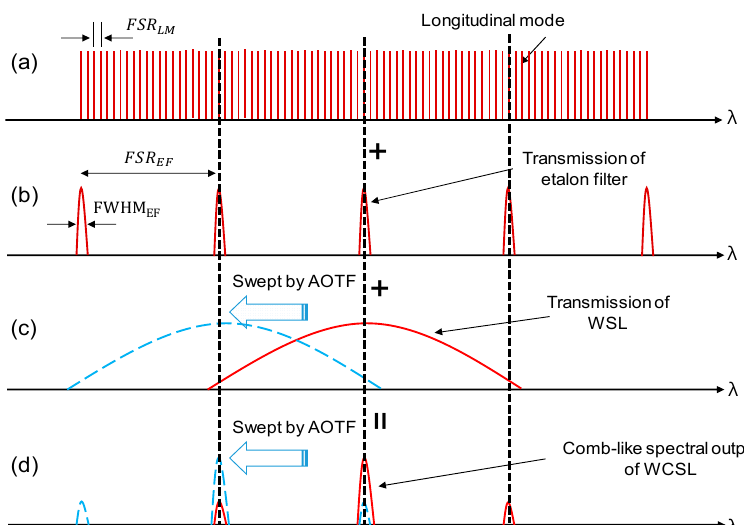
Figure 1. Generation of comb-like spectral laser source with narrow spectral linewidth by combining an etalon filter and an AOTF. ( a ) Longitudinal mode position corresponding to the round trip of the laser cavity; ( b ) transmission of the etalon filter; ( c ) transmission of conventional WSL; ( d ) comb-like spectral output of the WCSL. The transmission spectra swept by the AOTF for both the WSL and WCSL are also shown with dashed lines in ( c , d ), respectively.